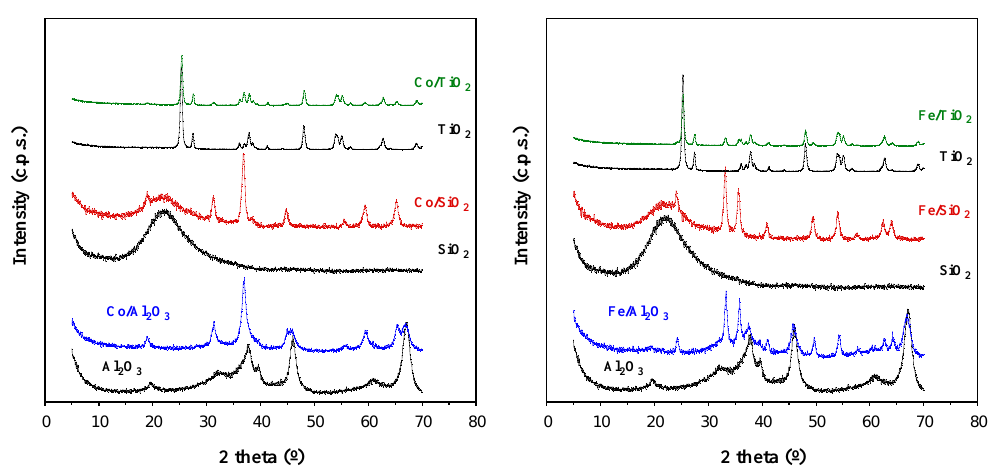
Figure 2. XRD patterns of the supported cobalt ( left ) and iron ( right ) oxide catalysts. Table 1. Textural properties derived from N 2 adsorption at −196 °C and metal content by inductively coupled plasma-atomic emission spectroscopy ICP-AES.